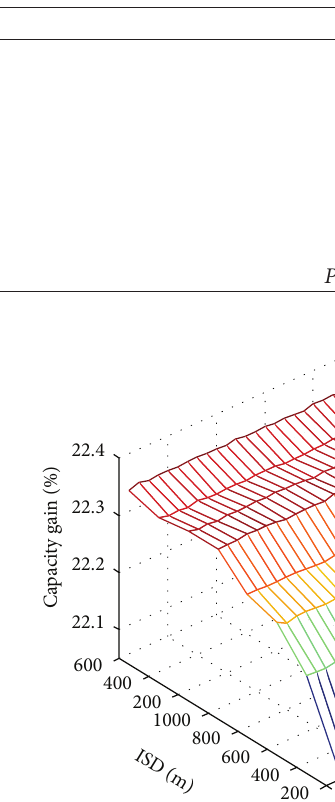
Figure 4: Capacity gain of CS-DAS over traditional cellular struc- ture.